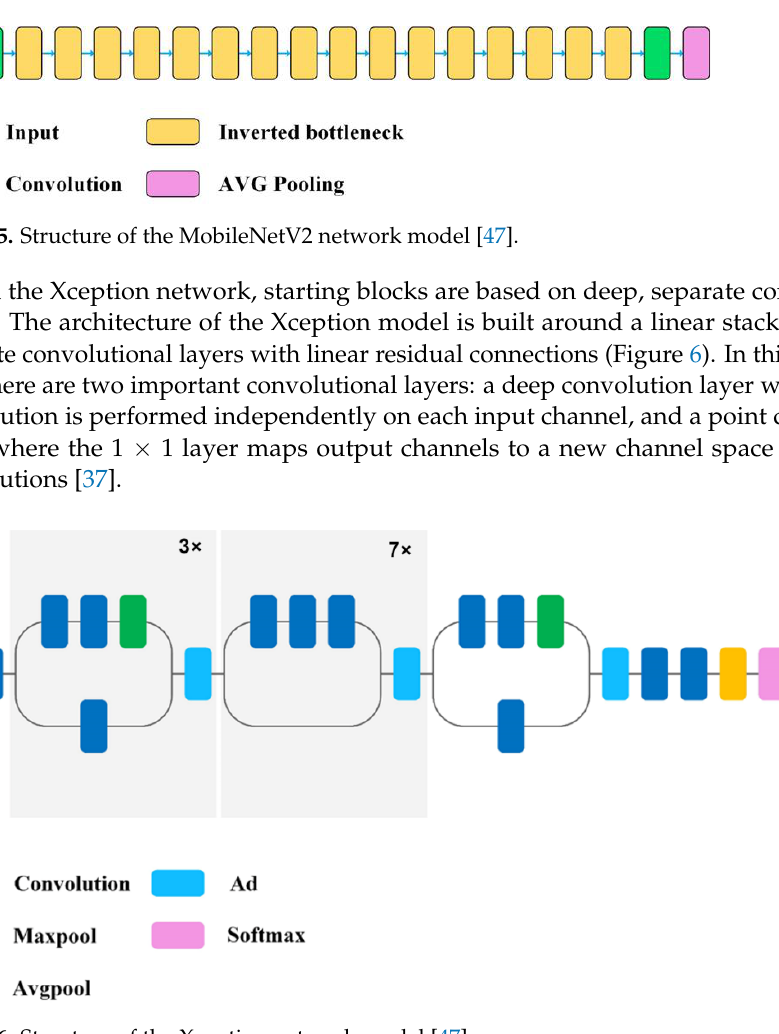
Figure 6. Structure of the Xception network model [47].